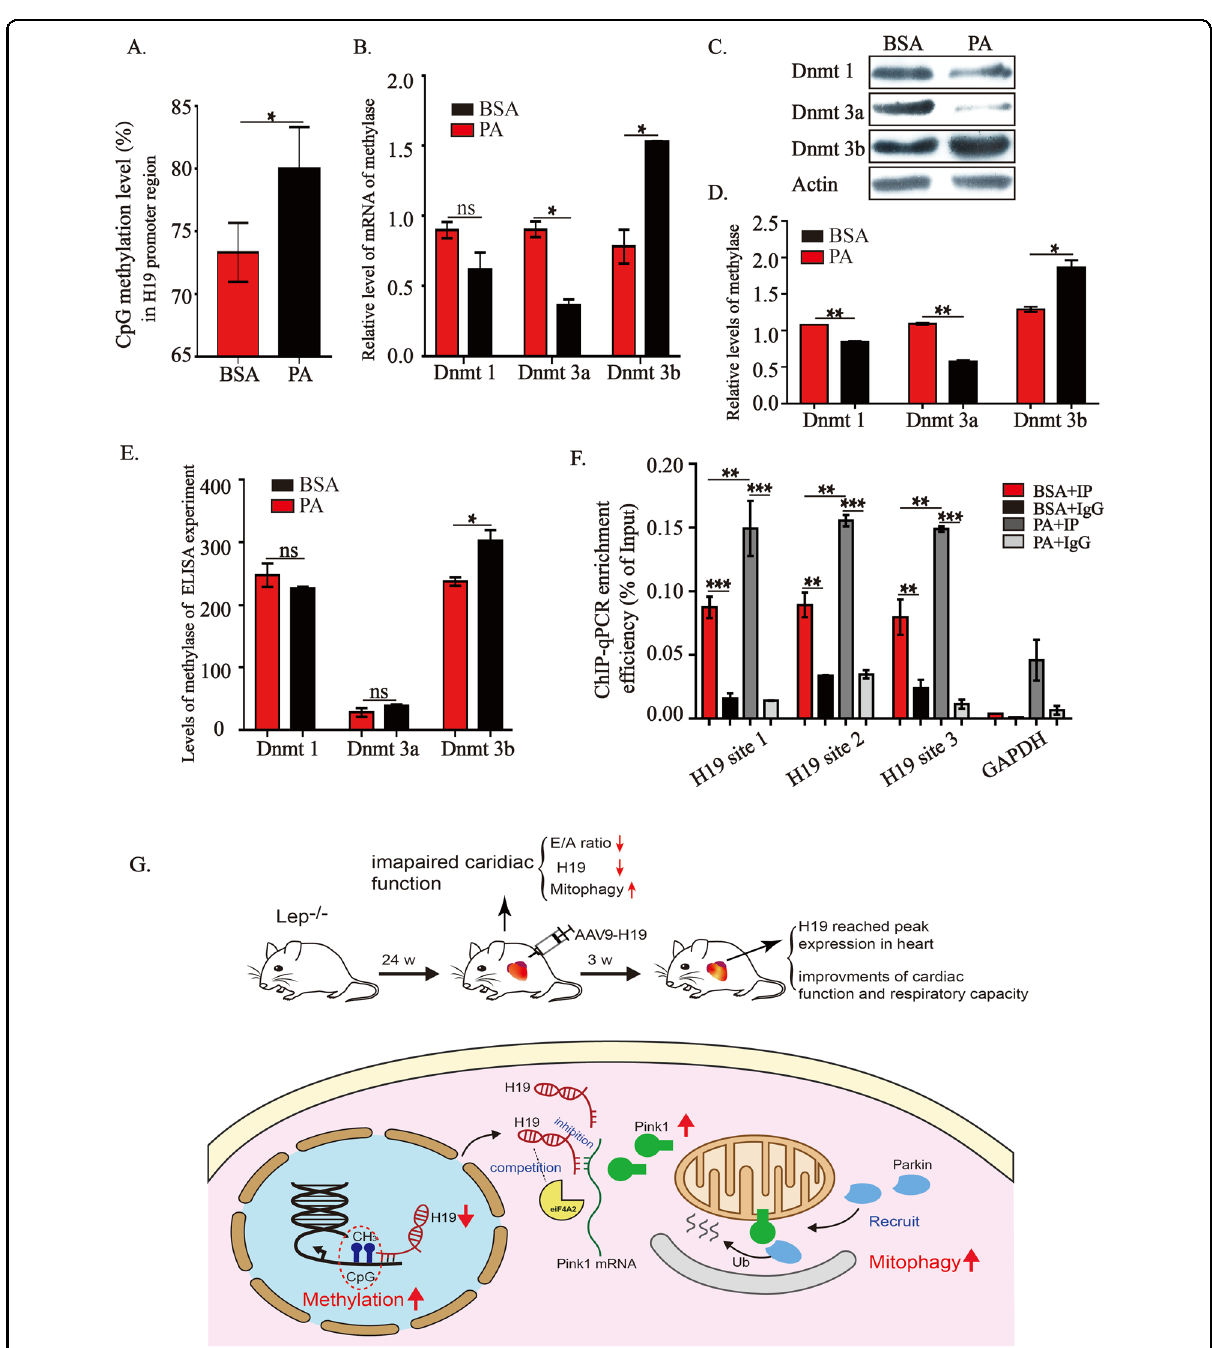
Fig. 6 PA promotes Dnmt3b activity and suppresses H19 expression. A Effects of PA on CpG island methylation levels in H19 promoter region. B – E Effects of PA on the expressions of Dnmt1, Dnmt3a and Dnmt3b mRNA ( B ) and proteins ( C and D ), and DNA methylation activity ( E ). F ChIP analysis using the anti-Dnmt3b antibody. G Schematic diagram representing the potential mechanism underlying H19-mediated regulation of mitophagy during obesity. Data in A , B and D – F are expressed as mean ± SEM. * P < 0.05; ** P < 0.01; *** P < 0.001. BSA, bovine serum albumin; PA, palmitic acid; Dnmt1, Dnmt3a or Dnmt3b, DNA methyltransferase 1, 3a or 3b; ChIP, Chromatin immunoprecipitation; RT-qPCR, quantitative reverse transcription polymerase chain